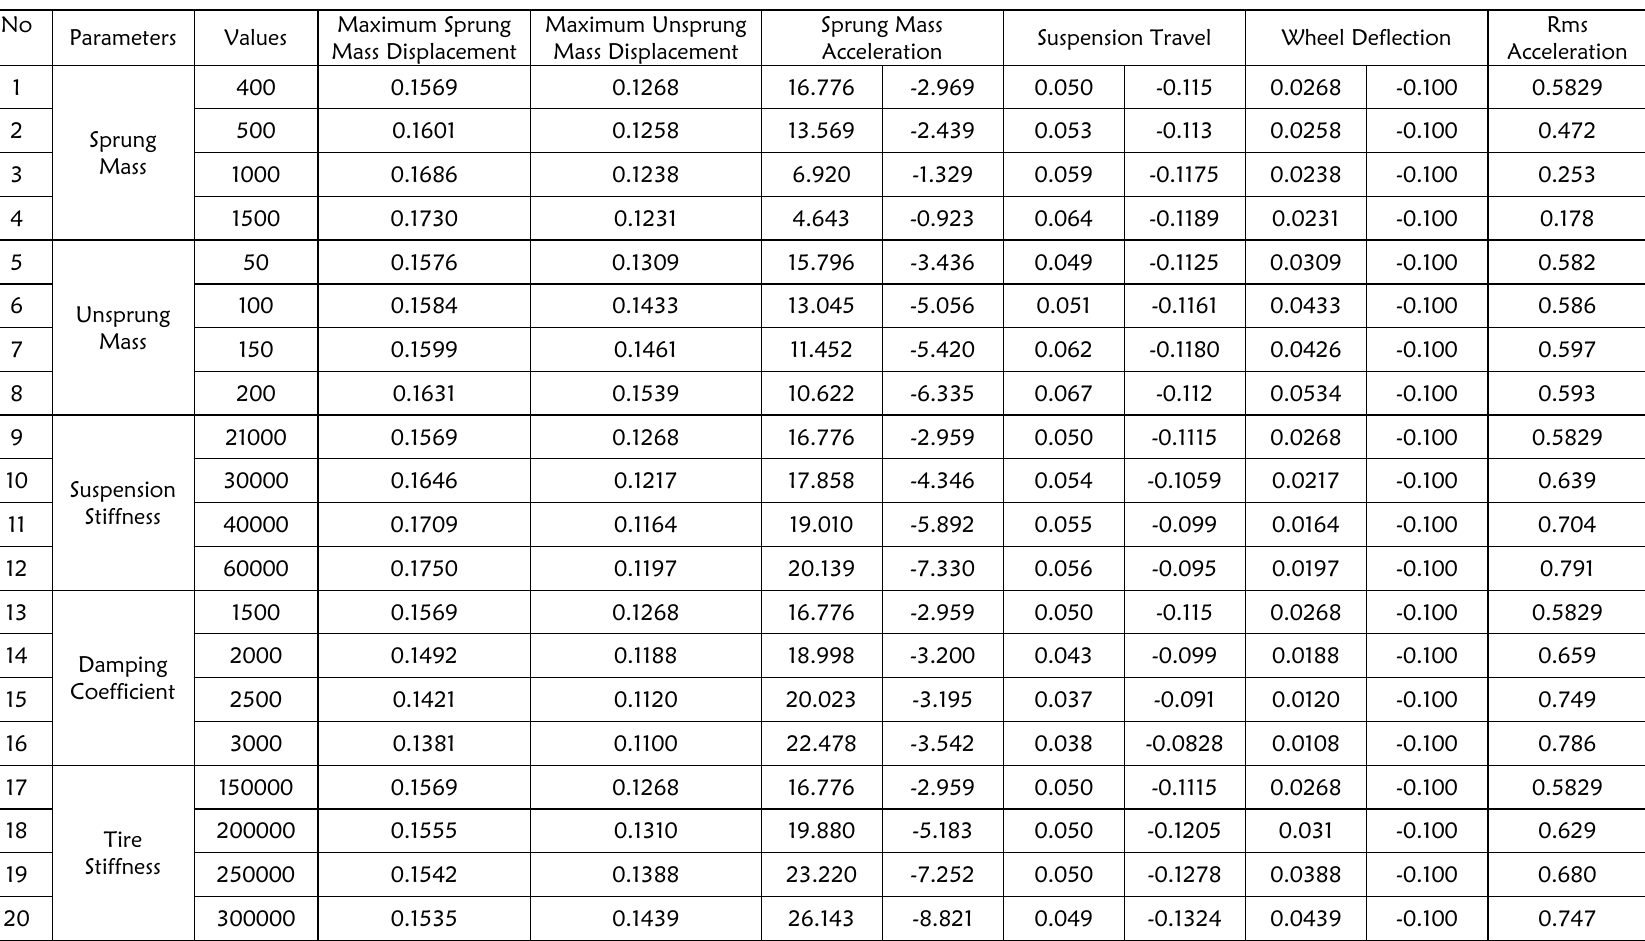
Table 3. Simulation results for quarter car